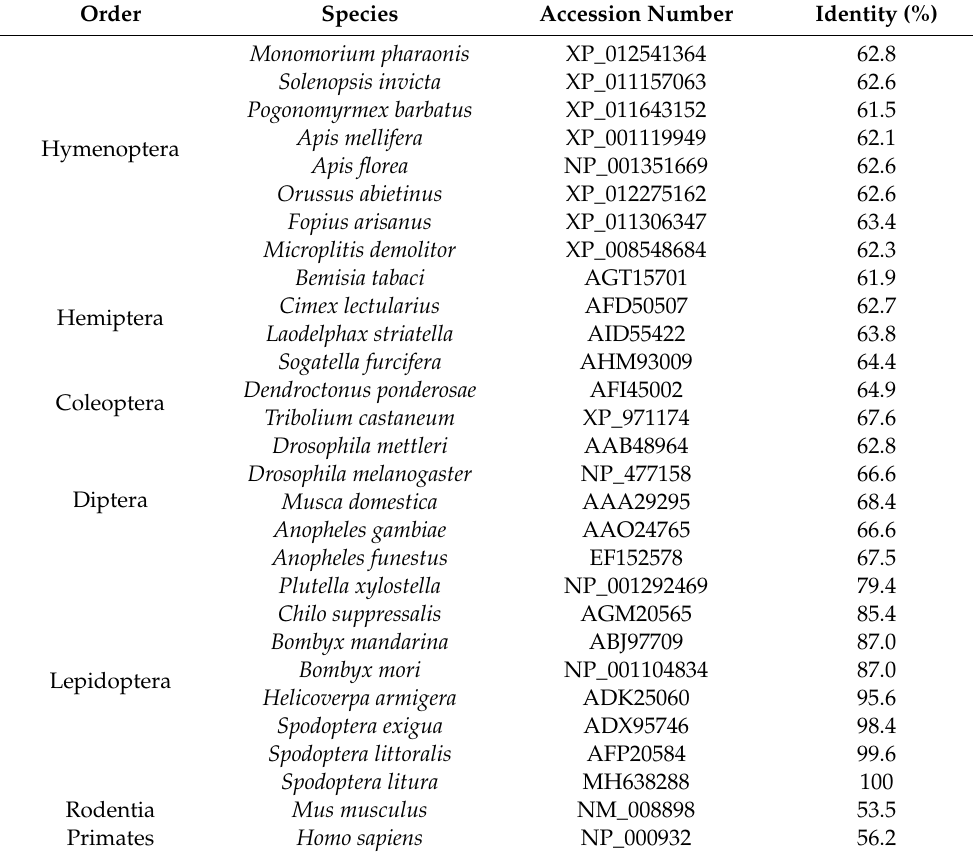
Table 1. Percent amino acid identities between SlCPR and other